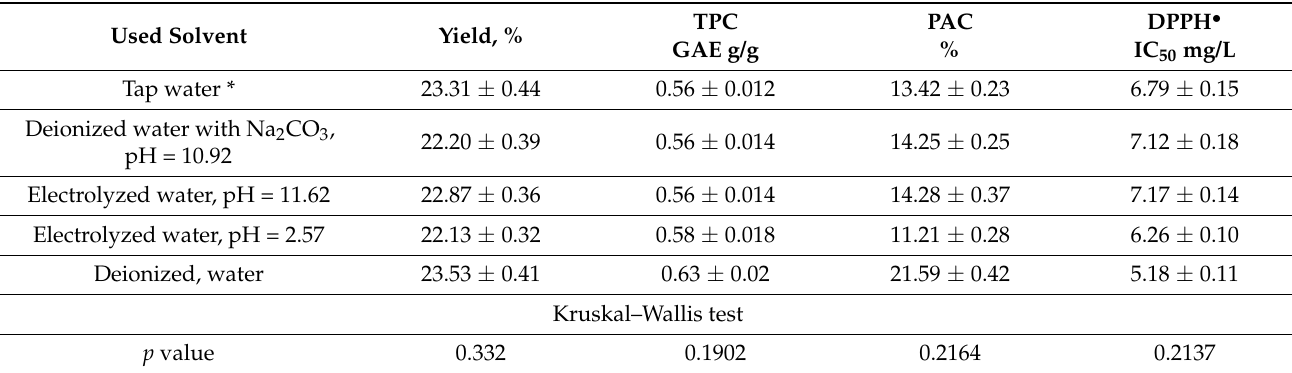
Table 1. Extraction yield, TPC, PAC and DPPH • of the extracts obtained during the single-step extraction at predefined extraction parameters.